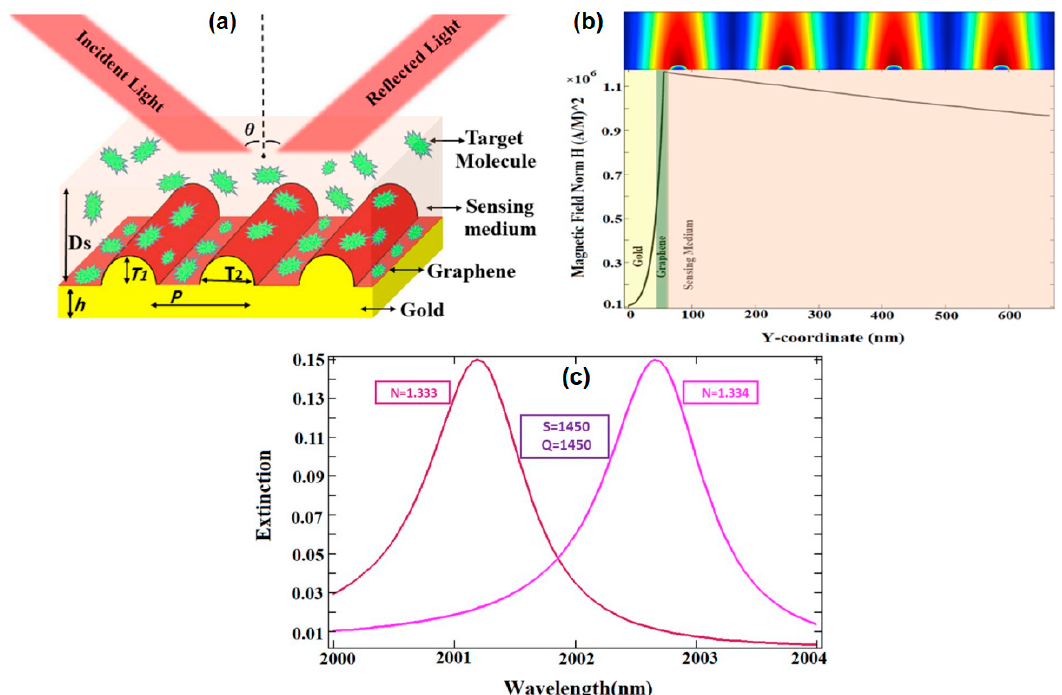
Figure 17. ( a ) A schematic diagram of graphene–gold grating. ( b ) The intensity distribution of the electromagnetic field at maximum wavelength of SPR mode. ( c ) SPR sensitivity investigations based on the shift in peak wavelength on the extinction curve (adapted with permission from Reference [74], copyright Elsevier).